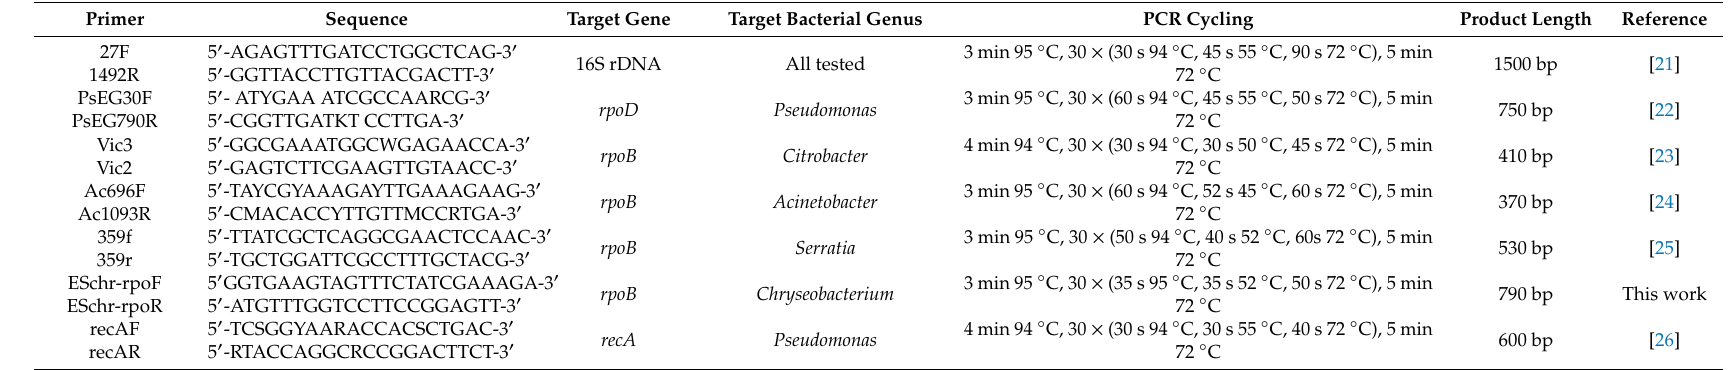
Table 3. Oligonucleotides used in the study.